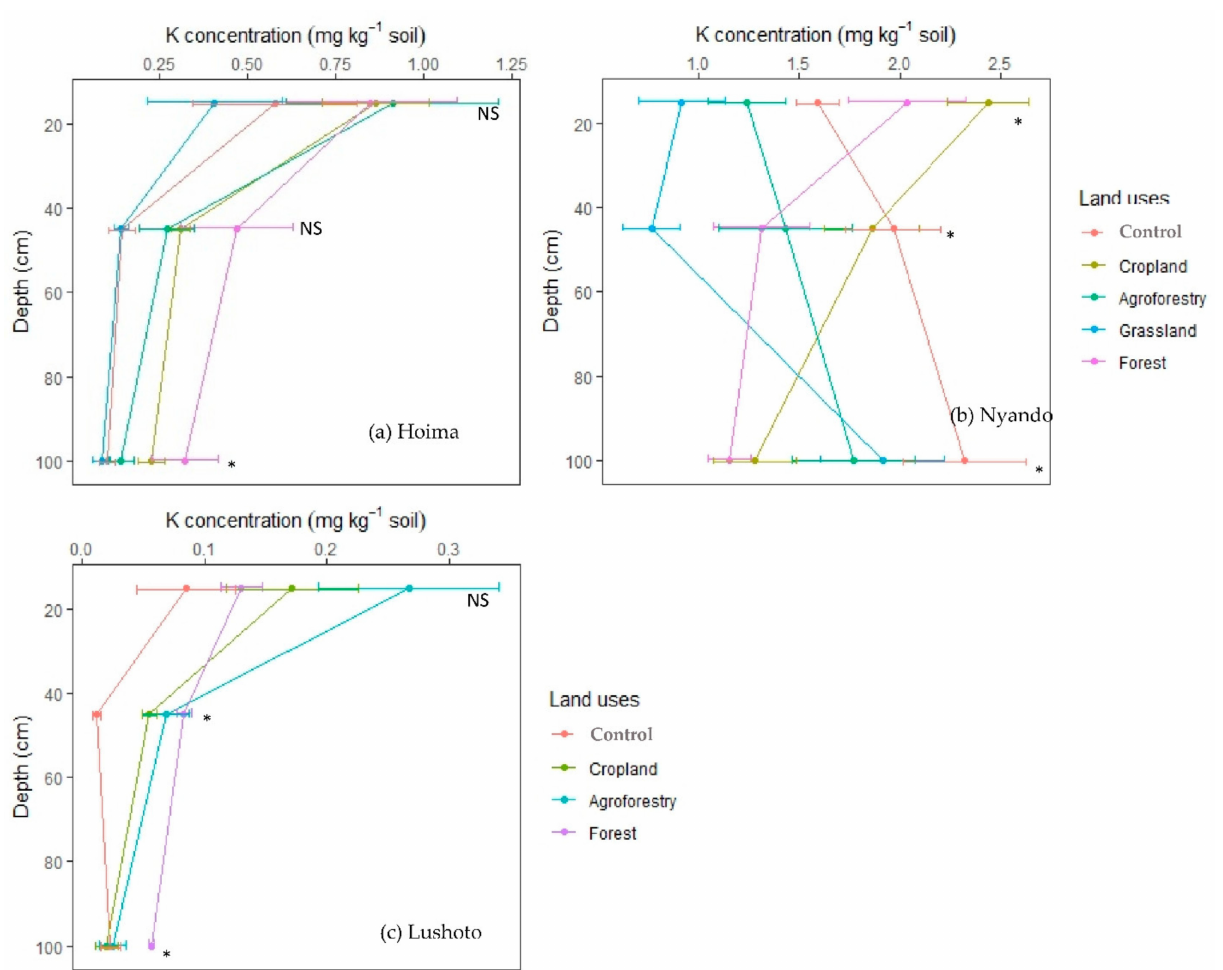
Figure 4. Potassium concentration Nitrogen concentration in ( a ) Hoima, ( b ) Nyando and ( c ) Lushoto at different land uses: cropland, agroforestry, grassland, forest, and control at different soil depths. Error bars represent the standard error of the mean. NS denotes nonsignificant differences; * denotes significant differences at p ≤ 0.05,